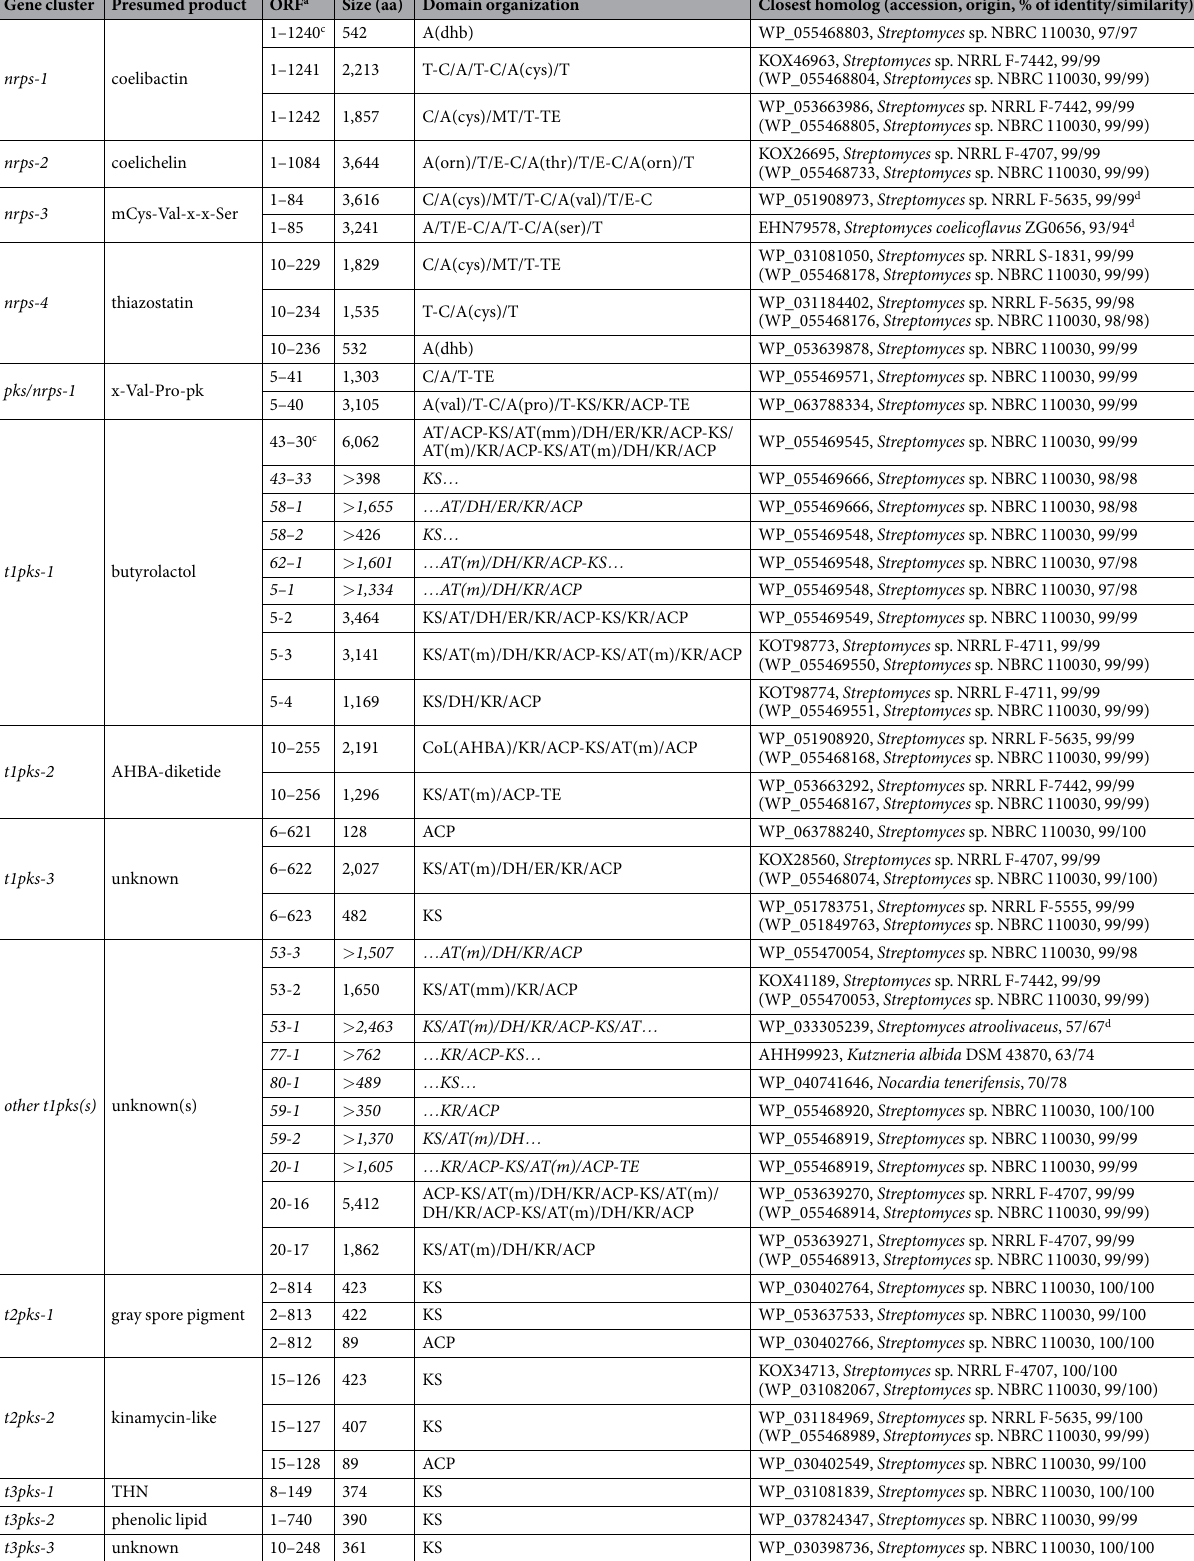
Table 4. ORFs encoding NRPSs and PKSs in NRPS and PKS gene clusters from S . diastaticus subsp. ardesiacus NBRC 15402 T . Abbreviations are the same as those of Table 2. a ORFs are shown as a combination of scaffold number and ORF number. Incompletely sequenced ORFs are shown in italics, and undetermined domains